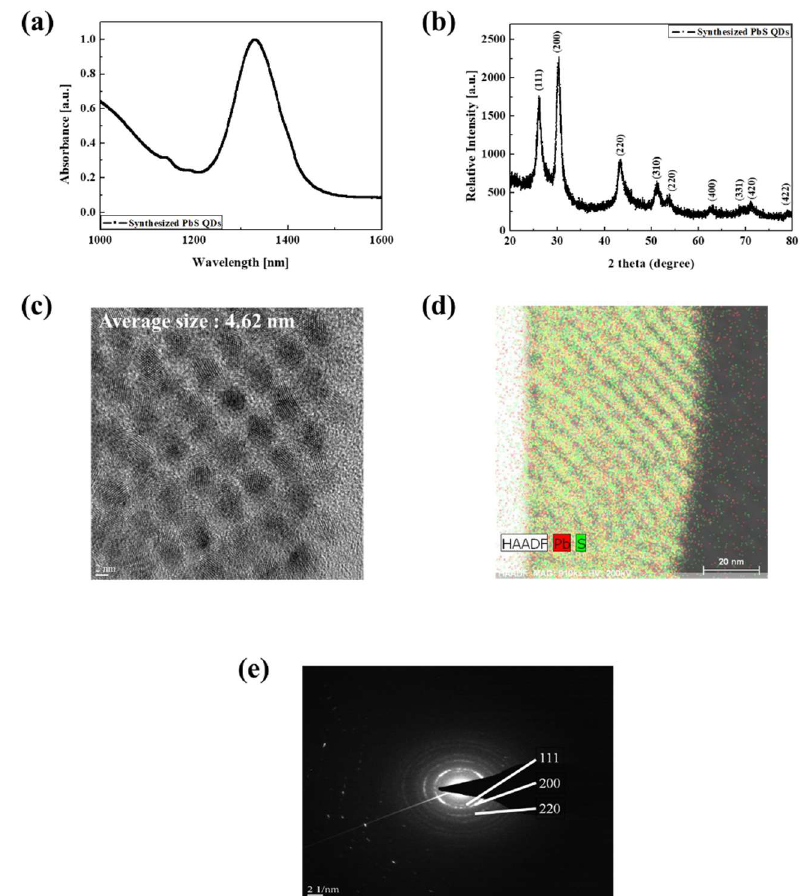
Figure 2. ( a ) Absorbance property, ( b ) XRD analysis, ( c ) TEM image, ( d ) composition analysis, and ( e ) diffraction ring of the synthesized PbS QDs.